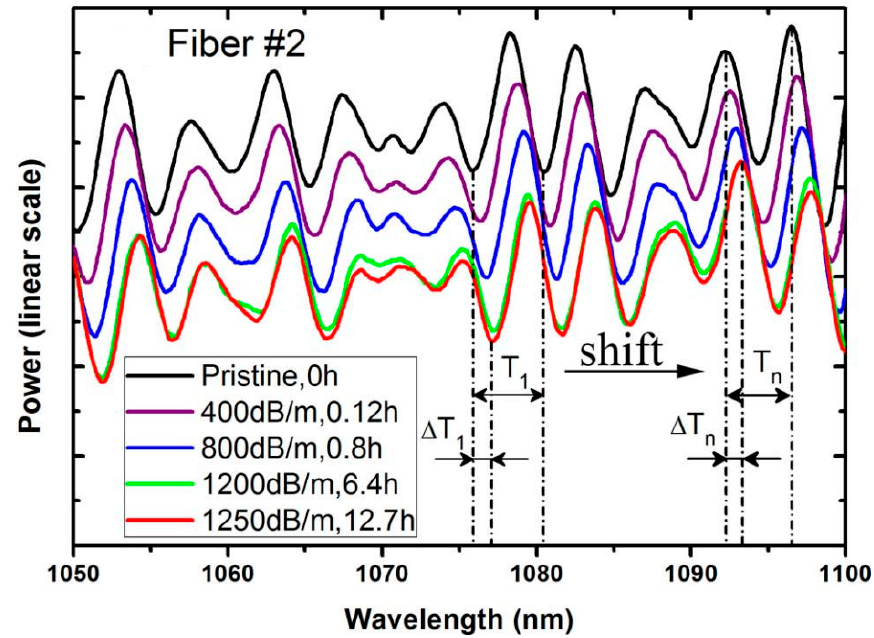
Figure 10. Observed phase shift in the modal interference fringes at various PD loss levels and corresponding times. Adapted with permission from [28] © The Optical Society.